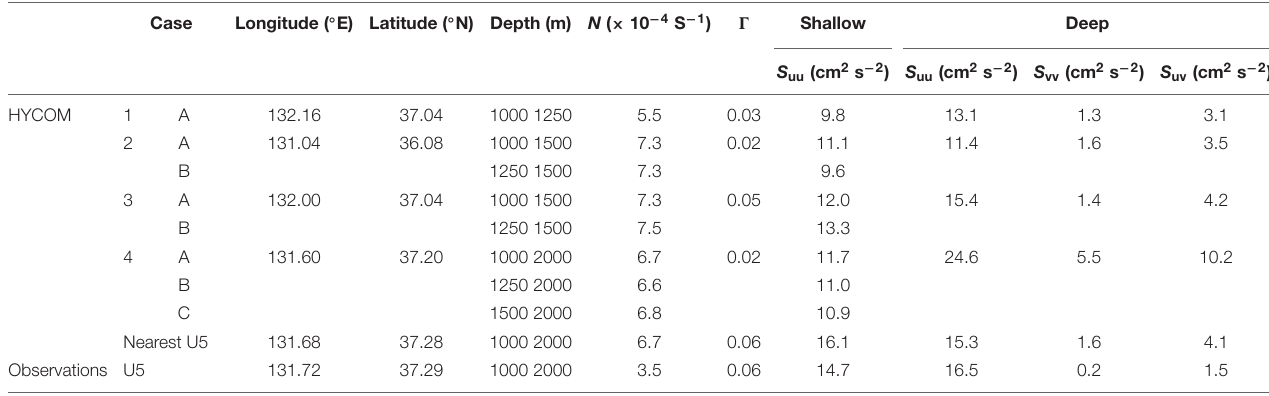
TABLE 2 | Inputs of TRW parameters.